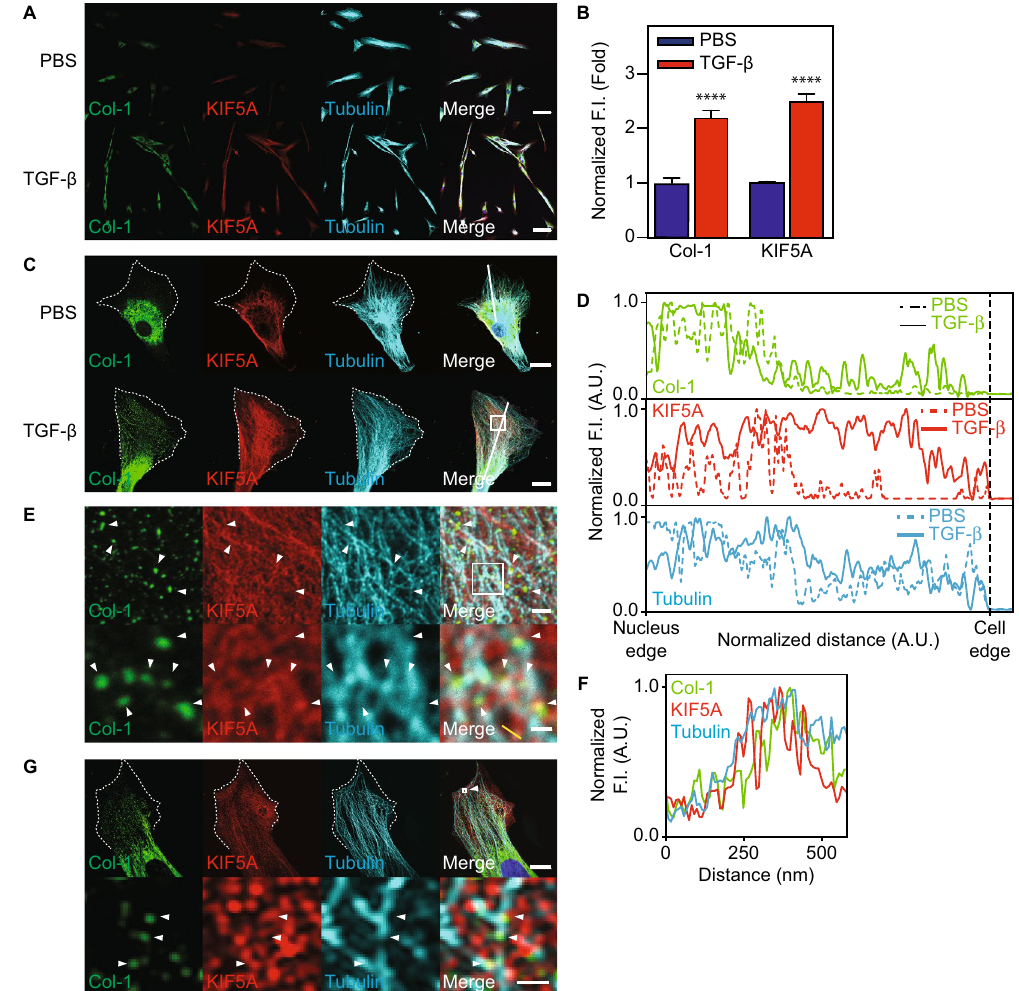
Figure 2. Effect of TGF- β on localization of KIF5A and Col-1 in HPMCs. ( A ) Confocal images of multiple HPMCs with or without TGF- β stimulation. Merge images include blue nucleus signal. Scale bar; 60 μ m. ( B ) Quantitative analysis of average fluorescent intensity inside the cells of A (n = 8 cells for PBS, n = 9 cells for TGF- β ). The intensity was normalized with the control. **** P < 0.0001 vs basal level. F.I., Fluorescent Intensity. ( C ) Confocal images of single HPMC with or without TGF- β stimulation. Merge images include blue nucleus signal. White dotted lines indicate the edge of cells. Scale bar; 20 μ m. ( D ) Quantitative line profile along white lines of C. F.I., Fluorescent Intensity. ( E ) Magnified images of intracellular structures. White box in C was magnified. White box in upper image was magnified to lower images. White arrows indicate colocalization among Col-1 and KIF5A and tubulin. Scale bar; 2 μ m in upper image, 0.5 μ m in lower image. ( F ) Quantitative line profile of co-localization along yellow lines of E. F.I., Fluorescent Intensity. ( G ) Superresolution images of single HPMC with TGF- β stimulation. Merge images include blue nucleus signal. White box with arrow in upper image was magnified to lower images. White dotted lines indicate the edge of cells. Scale bar; 10 μ m in upper image, 0.5 μ m in lower